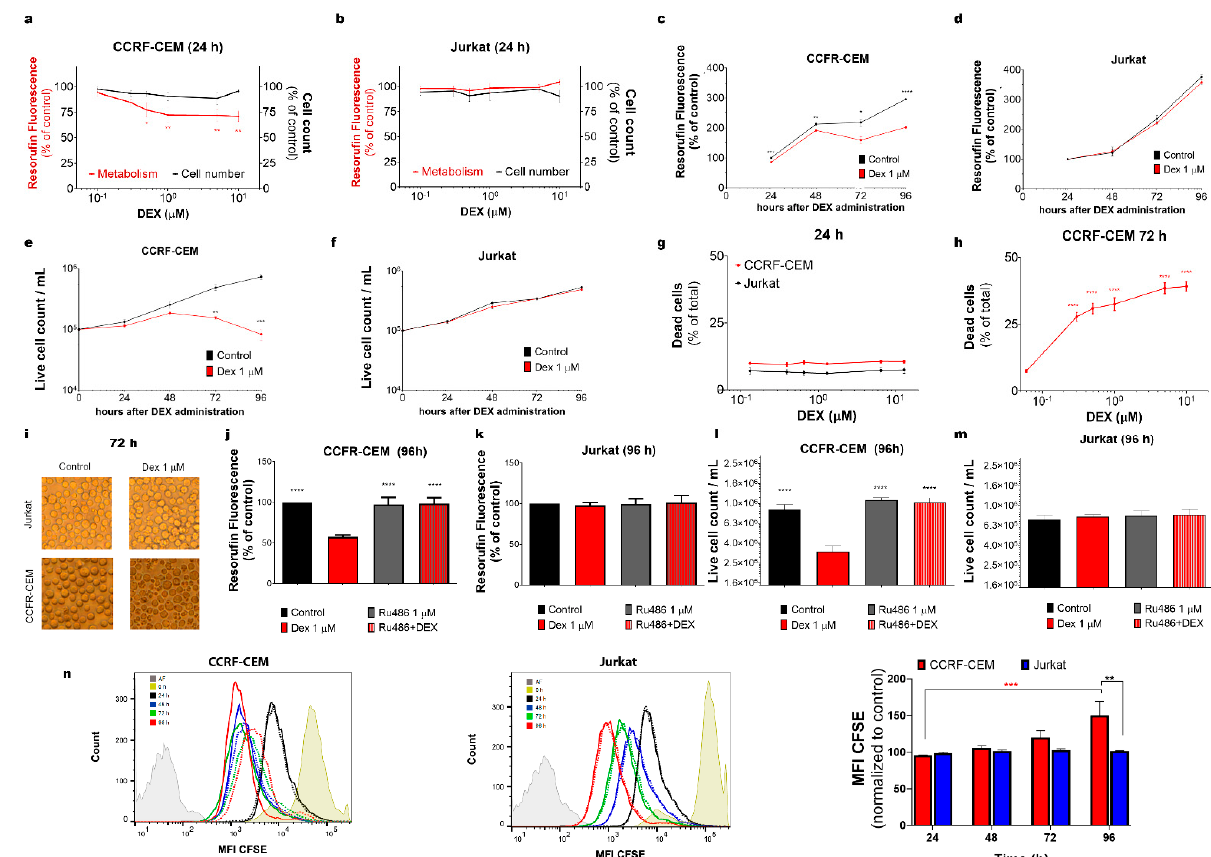
Figure 1. Validation of T-ALL models for GC resistance. ( a , b ) The effect of Dex (0–10 µ M) on cell metabolism (red traces) and cell count (black traces) was estimated at 24 h in CCRF-CEM ( a ) and Jurkat cells ( b ). One-way ANOVA with Dunnet’s multiple comparison test was employed. ( c , d ) The effect of Dex (1 µ M) on cell metabolism as a function of time (0–96 h) in CCRF-CEM ( c ) and Jurkat cells ( d ). ( e , f ) The effect of Dex (1 µ M) on live cell count was monitored (0–96 h) in CCRF-CEM ( e ) and Jurkat cells ( f ) using the trypan blue exclusion test. In ( c – f ), multiple t -tests were employed for each time point to compare control vs. treated groups. ( g , h ) Cell death of Dex (0–10 µ M)-treated cells was estimated using flow cytometry at 24 h ( g ) and 72 h ( h ). Total cell death includes apoptotic and necrotic cells, as evidenced by AnnexinV- Alexa488 and/and PI inclusion, respectively. One-way ANOVA with Dunnet’s multiple comparison test was employed. ( i ) Representative light microscopy micrographs (10 × ) of Jurkat and CCRF-CEM cells exposed to Dex (1 µ M, 72 h, right) in comparison to control (72 h, left). ( j , k ) Effects of Dex, Ru486, or their combination (1 µ M, 96 h) on CCRF-CEM ( j ) and Jurkat ( k ) metabolism. ( l , m ) Effects of Dex (1 µ M), Ru486 (1 µ M) or their combination on live cell count (96 h), in CCRF-CEM ( l ) and Jurkat ( m ). One-way ANOVA with Dunnet’s multiple comparison test was employed. ( n ) Cell proliferation estimated using CFSE-based flow cytometry in CCRF-CEM and Jurkat cells. Representative histograms for CCFR-CEM (left) and Jurkat (right) demonstrate the progress of cell proliferation as a leftward shift of the mean fluorescence intensity (MFI), reflecting cell divisions by dye dilution. Solid and dashed lines are for Dex-treated and control cells, respectively. Bar-chart at the right displays the ratio Dex/control MFI at each time. Two-way ANOVA with Sidak’s multiple comparison test was employed to compare relative MFI values for Jurkat and CCRF-CEM at different times against MFI at 24 h. In ( a – d , g , h , j – n ), raw data were normalized to the control group. Wherever applicable, data are mean ± S.E. for 3 to 7 independent experiments. * p < 0.05; ** p < 0.01; *** p < 0.001; **** p <